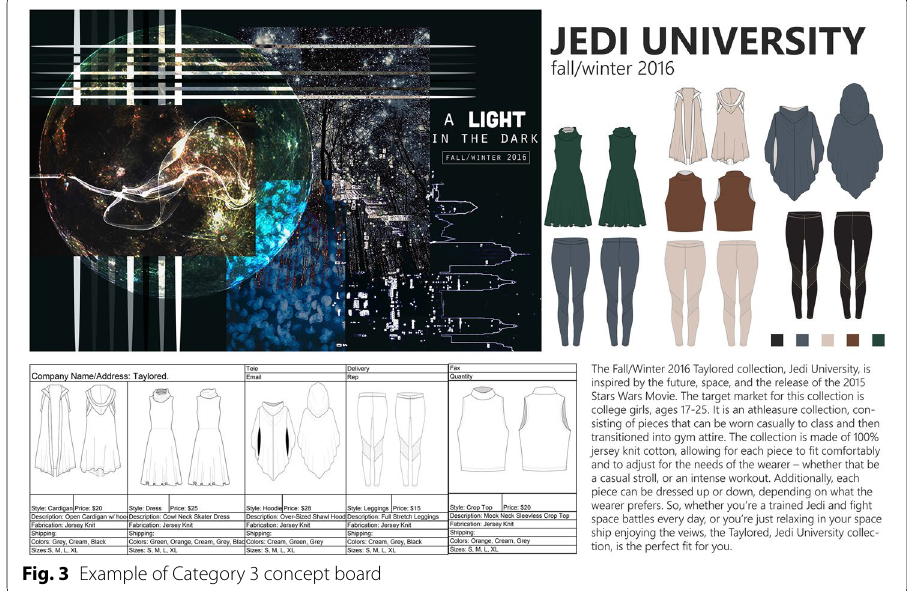
Fig. 3 Example of Category 3 concept board